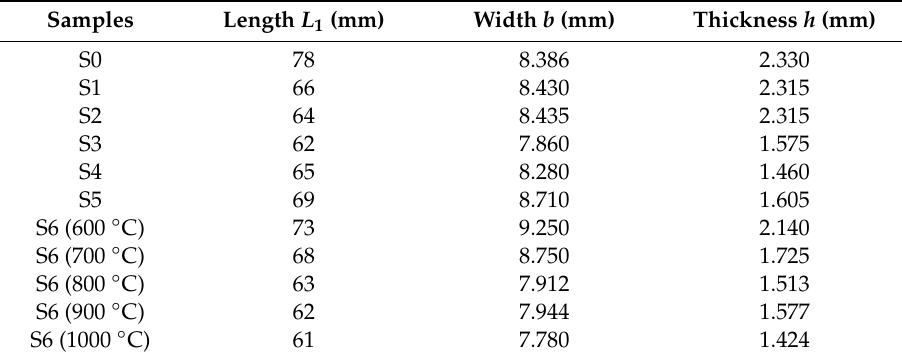
Table A1. The average geometry parameters of the ceramic samples.